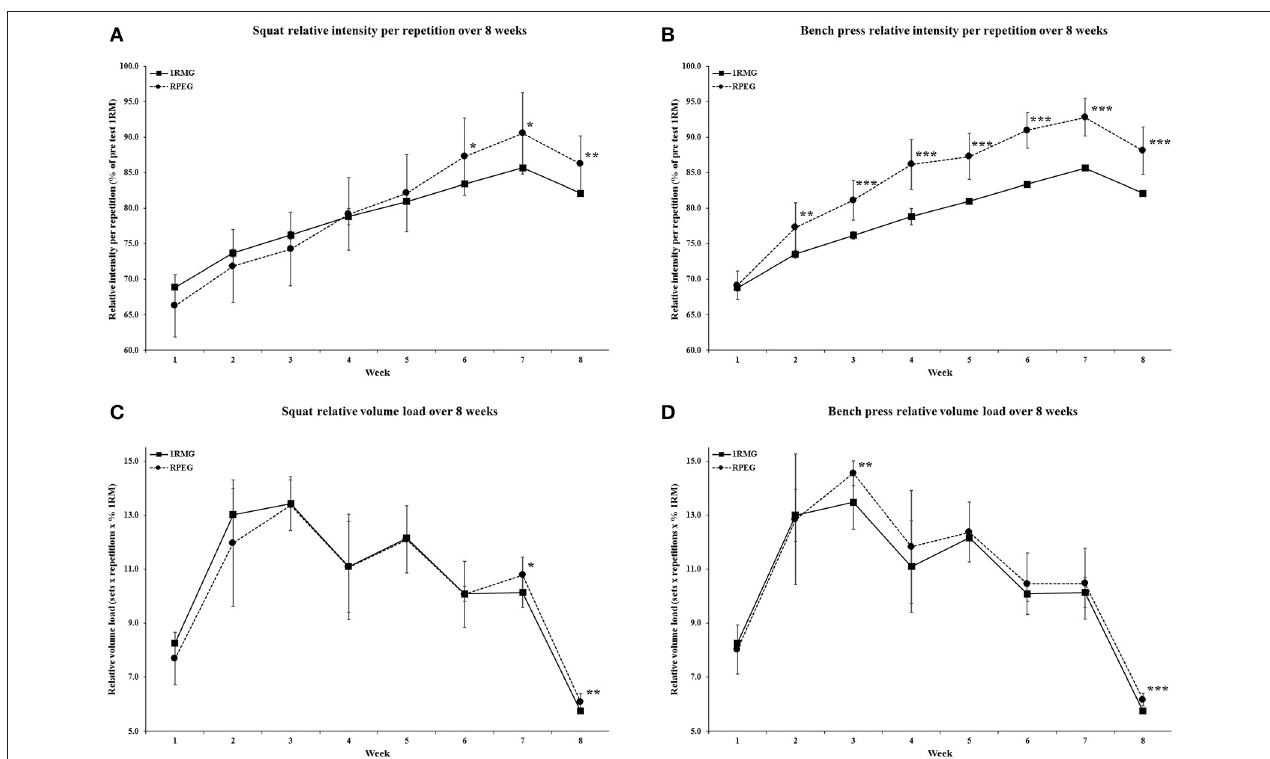
FIGURE 2 | Weekly average values for (A) intensity relative to pre-test 1RM per repetition for squat, (B) bench press and (C) volume load relative to pre-test 1RM for squat and (D) bench press. * p < 0.05, ** p < 0.01, and *** p < 0.001. 1RM, one repetition